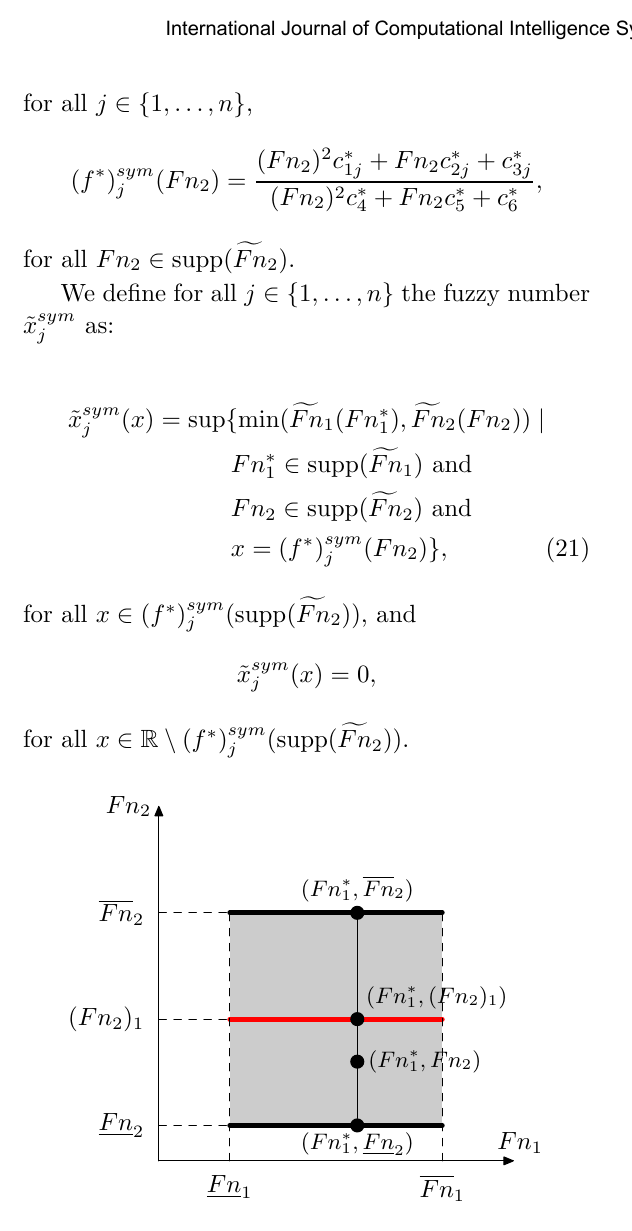
Fig. 2. Solving systems with two fuzzy coef- ficients where the second fuzzy number is a non-diagonal element of the matrix ˜ A .